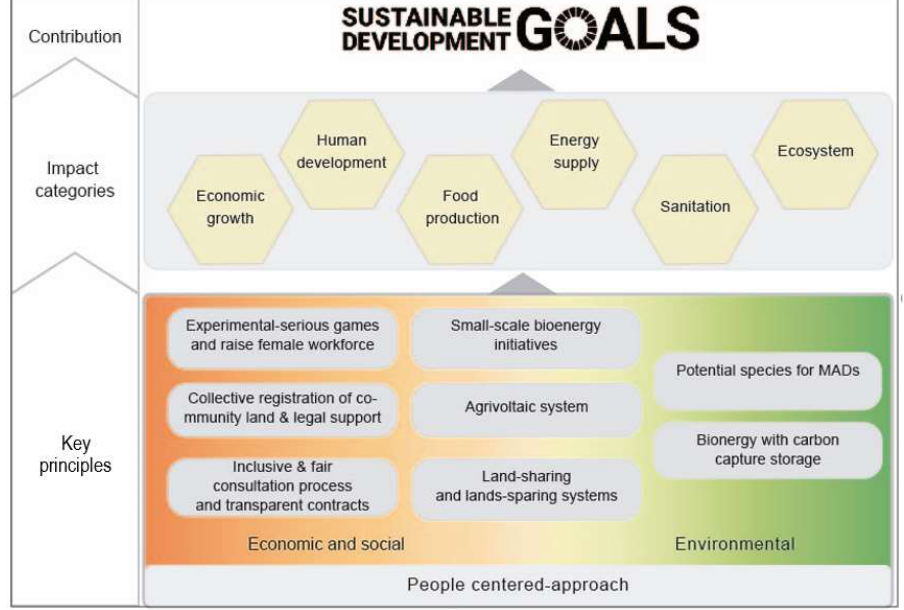
Figure 9. Key principles for the sustainable development of bioenergy cropping systems on marginal African drylands.